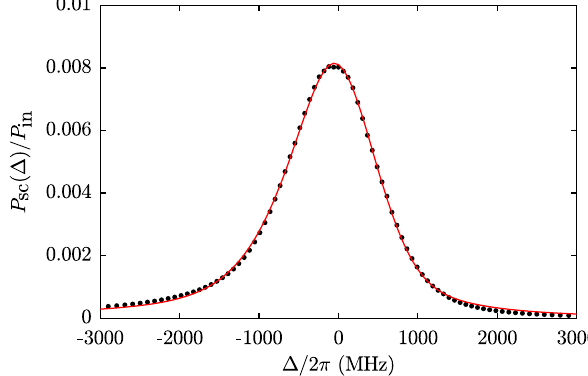
FIG. 4. Simulation result for the w d ¼ 150 nm slot waveguide. The black dots show the scattered power P normalized by the sc input power P as a function of detuning Δ . Also shown is in the corresponding Voigt fit (red line), from which we extract the relevant line shape